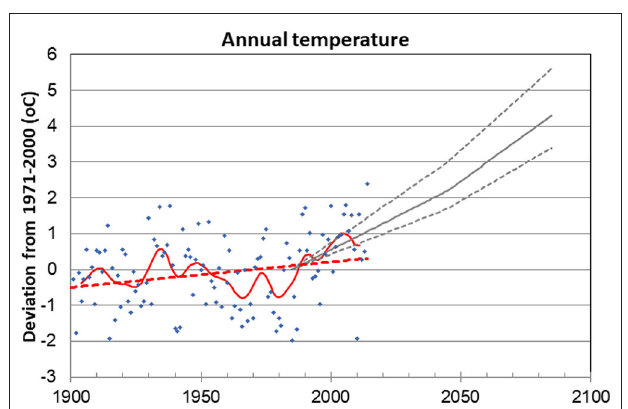
FIGURE 2 | Historical and projected annual mean temperature for one county, Hedmark. The historical development is shown as single years (blue dots), smoothed 10-year variations (full red line), trends (dotted red line). The future development is shown for the high emission scenario, RCP8.5, as the median of the model ensemble (full gray line) and low and high model simulations (dotted gray lines), for the middle of this century (the period 2031–2060 is plotted at 2045) and the end of this century (the period 2071–2100 is plotted at